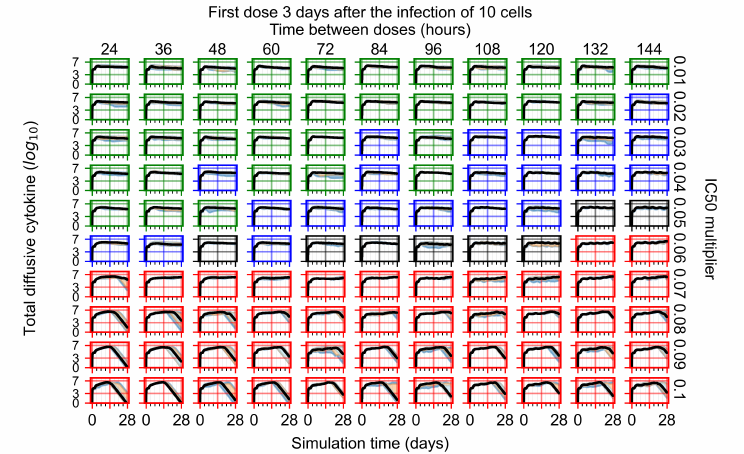
Figure A36. Diffusive cytokine amount, Y axis in log scale, and exponent values as tick marks.